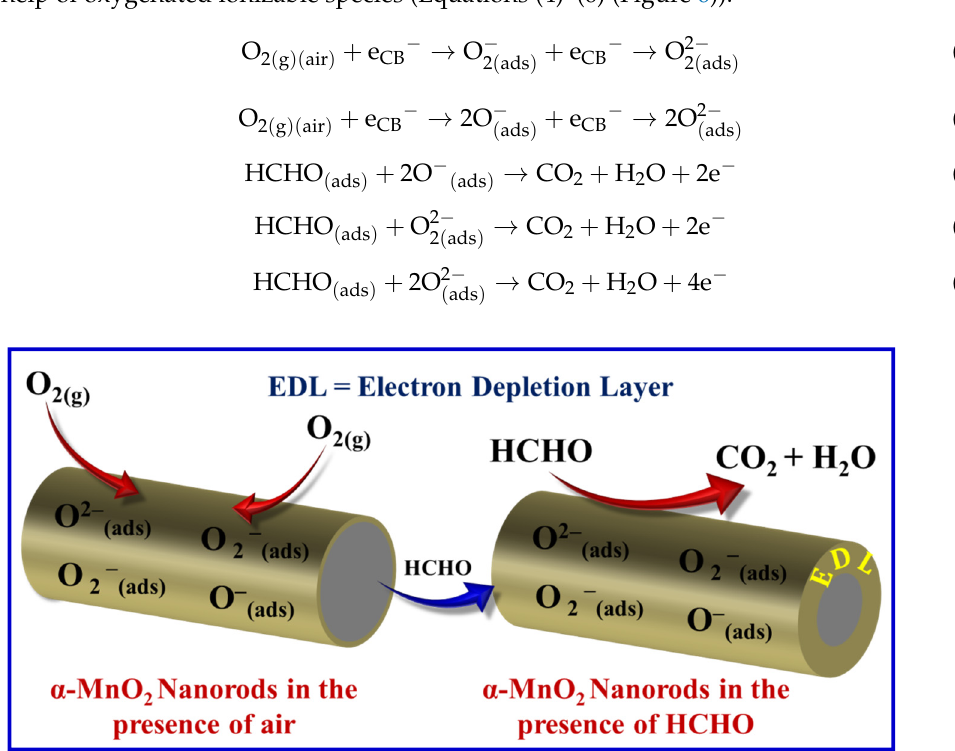
Figure 6. Proposed mechanism for HCHO sensing by α -MnO 2 nanowire-based gas sensor.